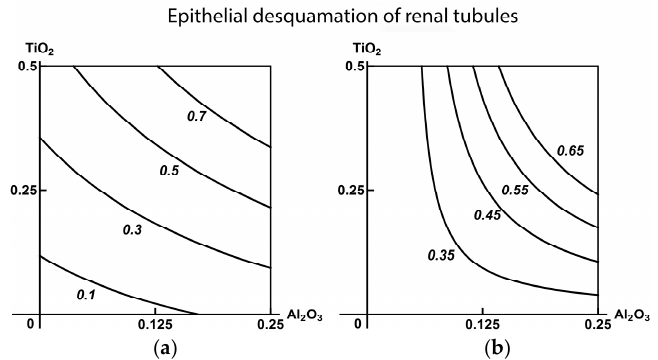
Figure 7. Isoboles of combined subchronic toxicity of Al 2 O 3 -NP + TiO 2 -NP assessed by epithelial desquamation of renal tubules: ( a ) additivity of unidirectional action in the absence of a third MeO-NP; ( b ) superadditivity in the presence of SiO 2 -NP (an example of a three-factor action falling within class A). The axes represent doses of corresponding MeO-NPs in mg per rat; the numbers at the isoboles denote the magnitude of the effect (expressed in %).